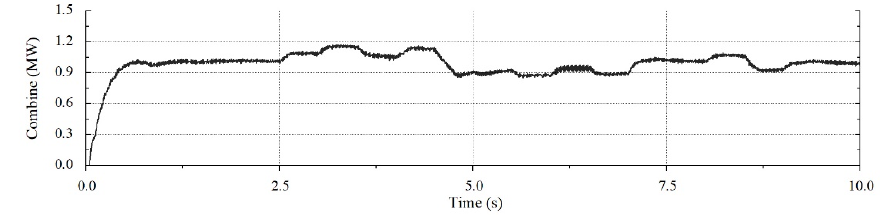
Figure 10. Combined power production of DC network (ESS ‐ strict voltage control).